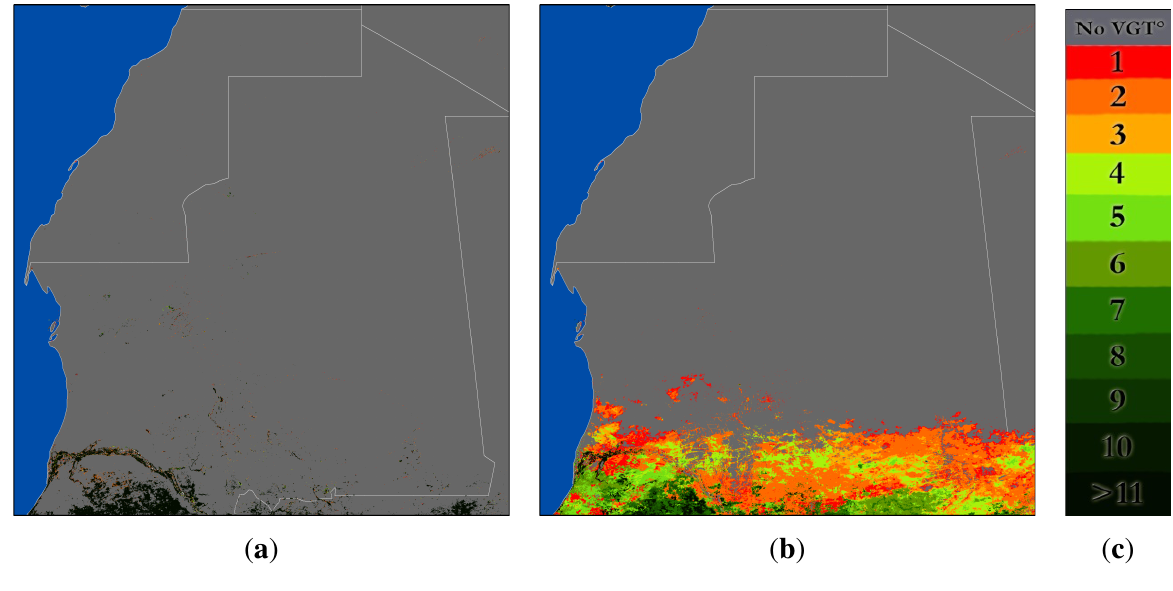
Dynamic greenness map products for Mauritania on two contrasted dates: ( a ) second decade of February 2011; and ( b ) first decade of September 2011; ( c ) the color code of the time meter. This illustrates the spatial-temporal variability of vegetation and the vegetation response to seasonal rainfall. The product with its time meter flags priority areas to be surveyed (warm colors) because of a recent greening of vegetation becoming suitable for locusts, as they prefer fresh vegetation. On the contrary, dark-colored areas present a lower interest for